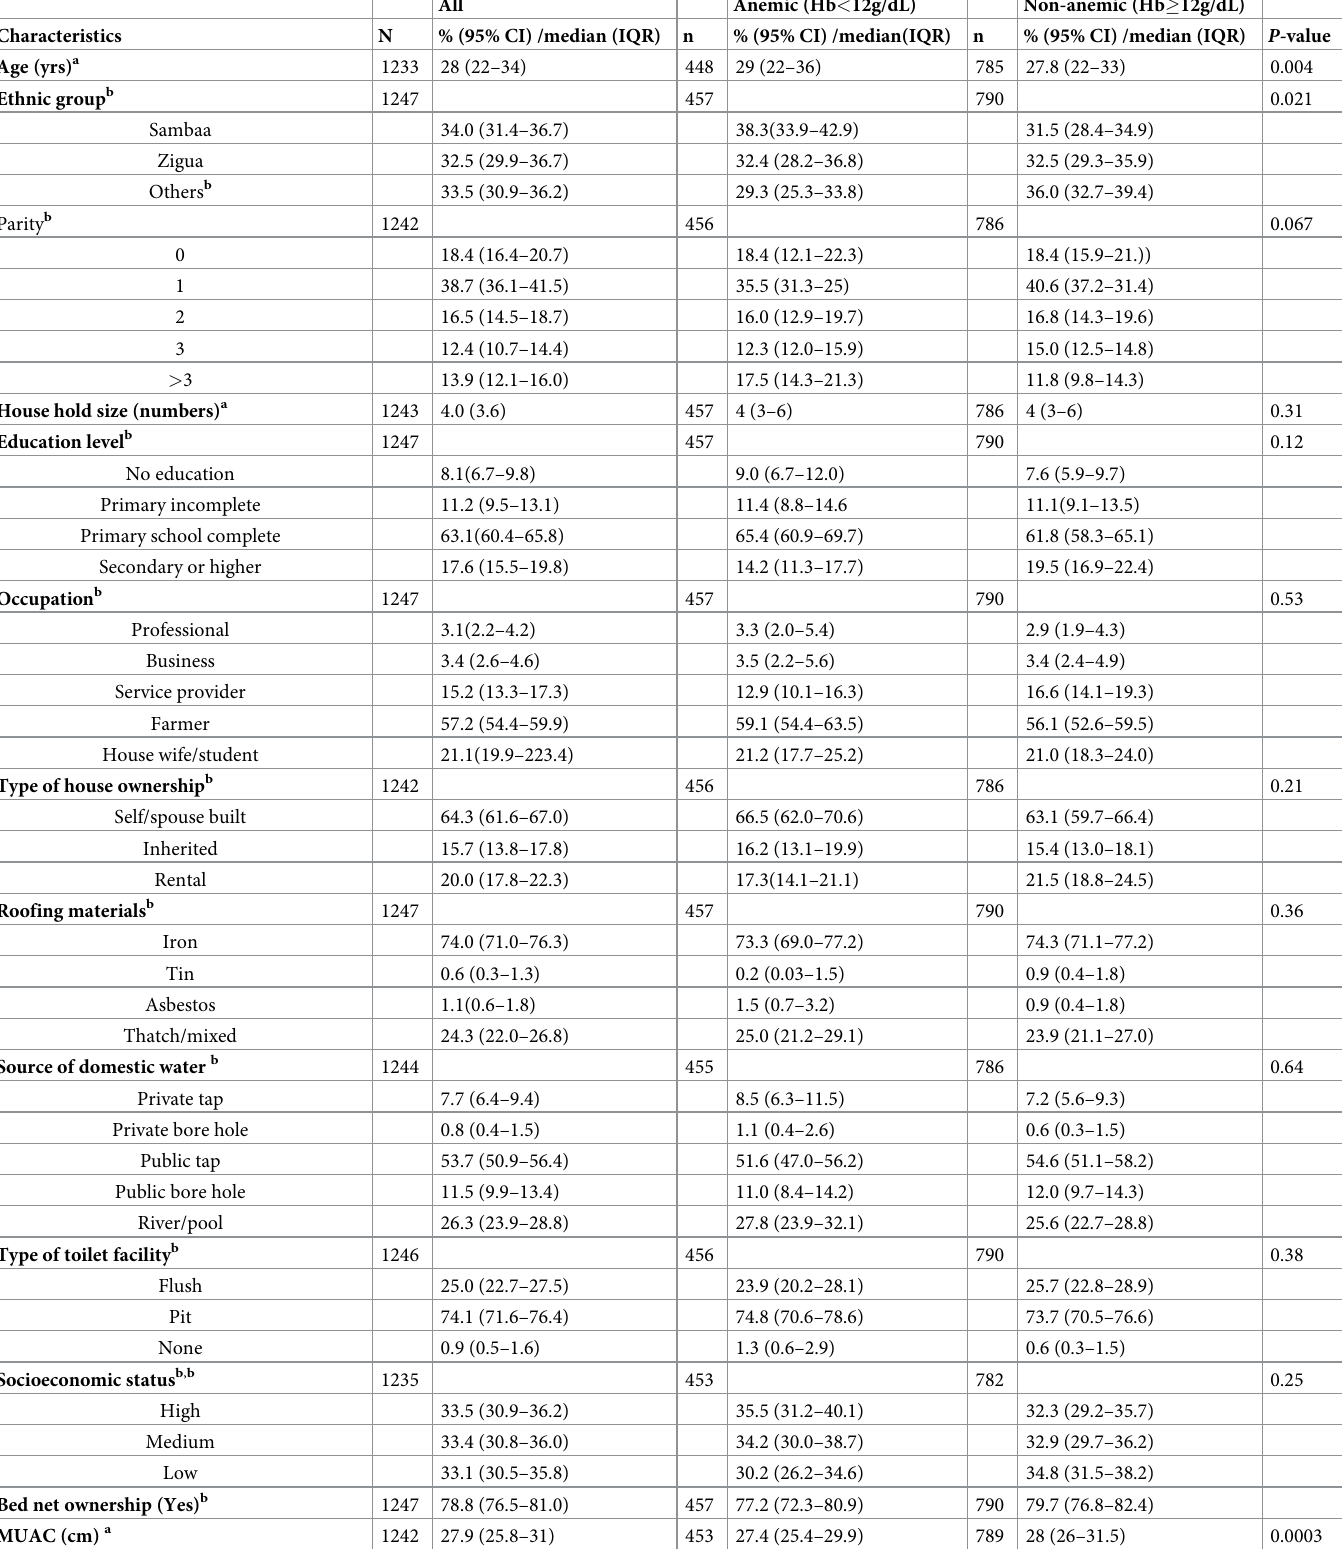
Table 1. Baseline characteristics of women before pregnancy in north eastern Tanzania. All Anemic (Hb < 12g/dL) Non-anemic (Hb �